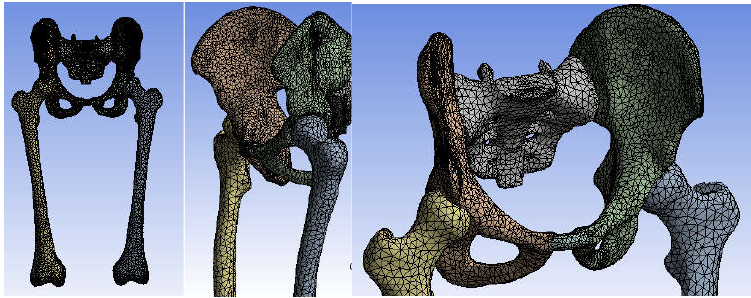
Figure 34. Finite element structure of the system under analysis.